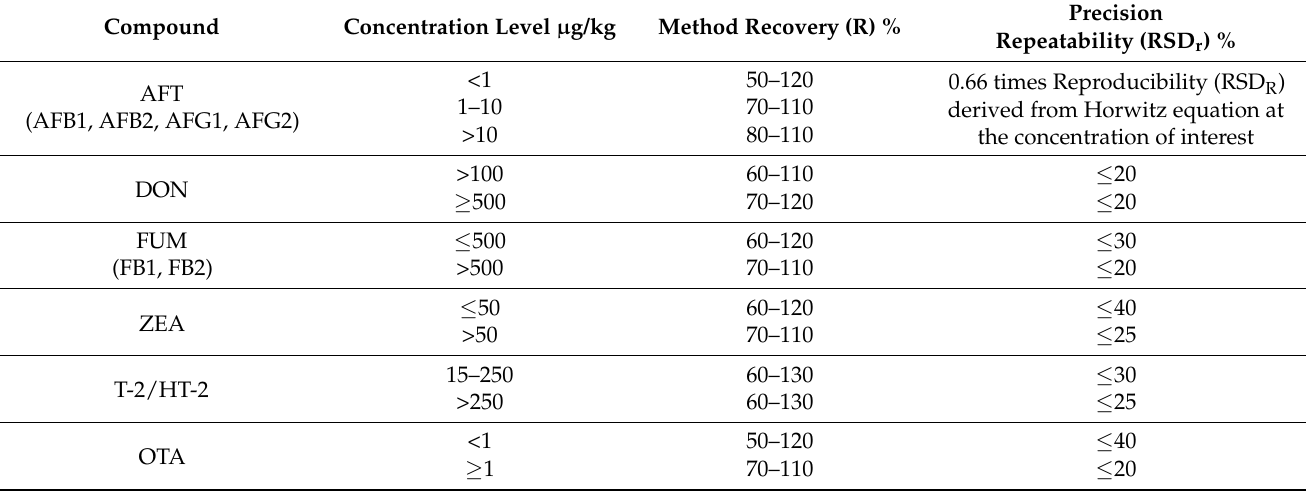
Table 2. Selected performance criteria values (trueness, precision) according to Commission Regula- tion (EC) No. 401/2006